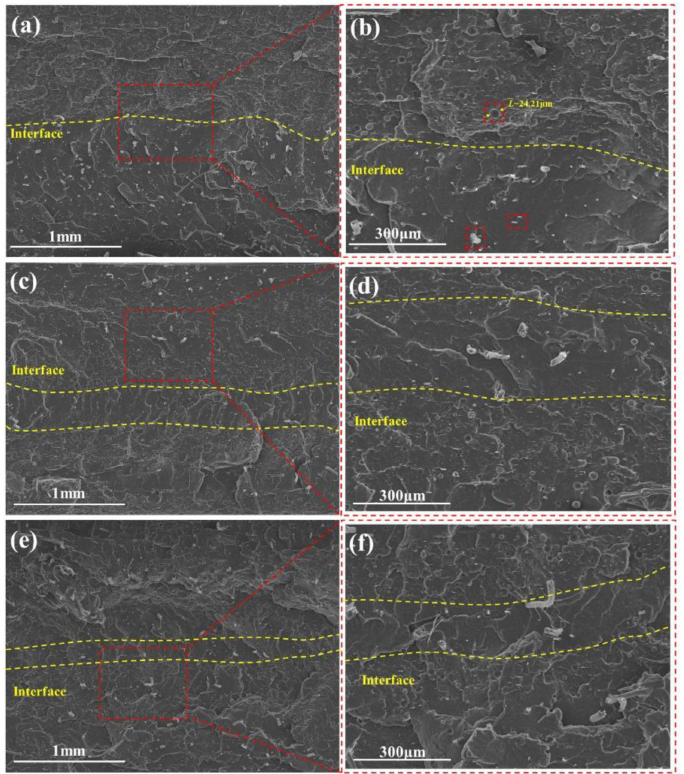
Figure 6. Cross-sectional SEM images of the multilayer EPDM composites: ( a ) (AM/HM) 10 , ( c ) (AM/HM) 40 , ( e ) (AM/HM) 80 ; ( b , d , f ) are the partial magnification of ( a , c , e ),